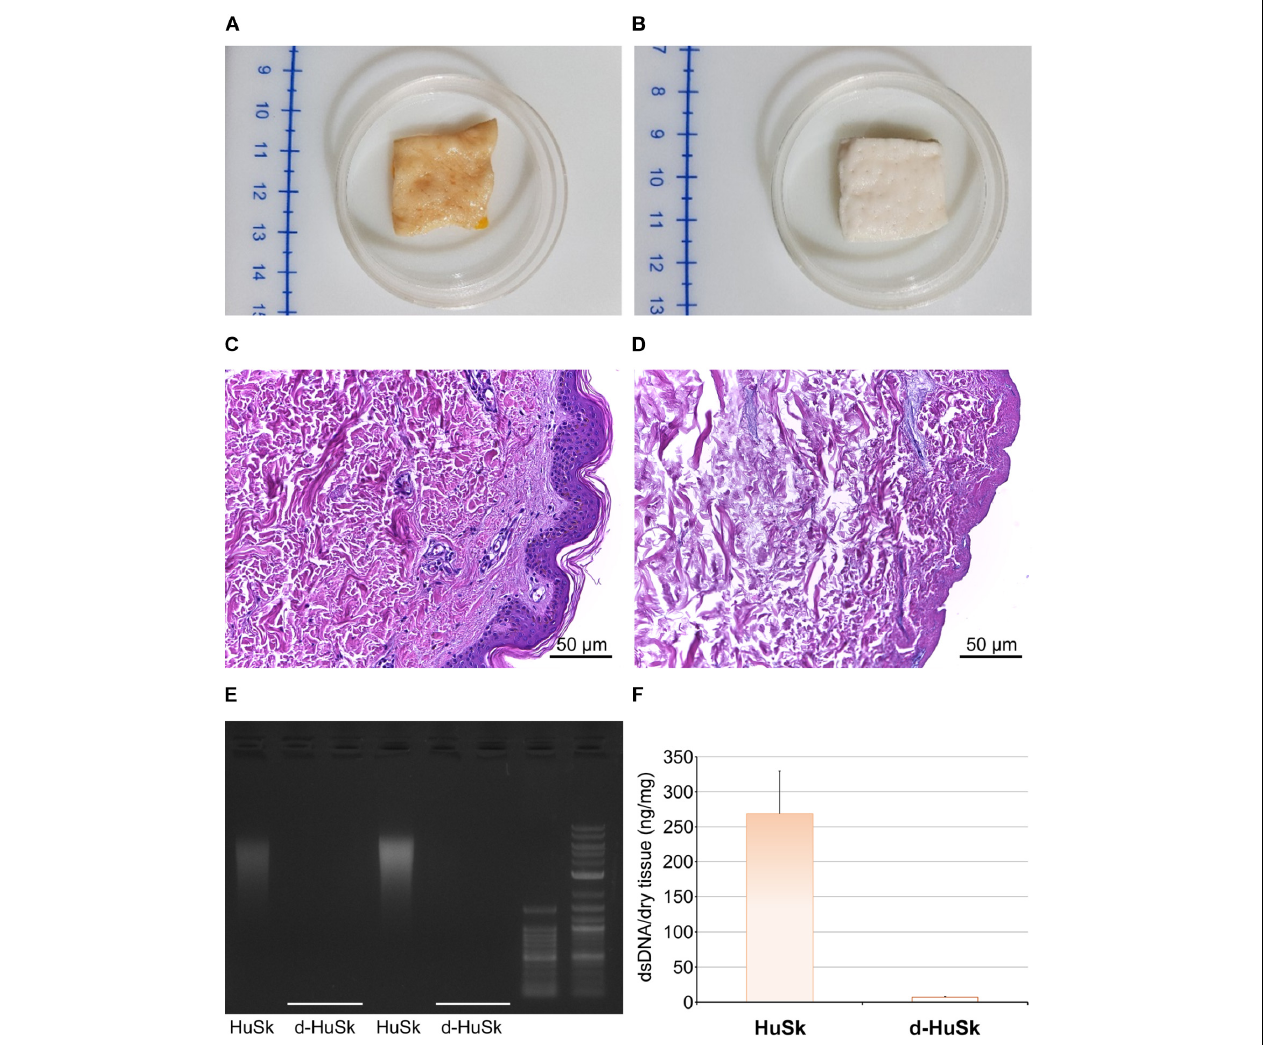
FIGURE 1 | Evaluation of the effectiveness of the decellularization procedure of adult human skin. Representative images of macroscopic examination of native human skin (HuSk) (A) and decellularized human skin (d-HuSk) (B) showing an obvious change in color after decellularization. Representative images of hematoxylin and eosin staining comparing HuSk (C) with d-HuSk (D) and showing the preserved tissue architecture and the absence of nuclei in d-HuSk (Scale bar: 50 µ m). (E) Representative gel electrophoresis revealing an extremely low content of residual dsDNA in d-HuSk when compared with HuSk. (F) Quantification of dsDNA in d-HuSk showing a content well below that of HuSk and the proposed criterion of 50